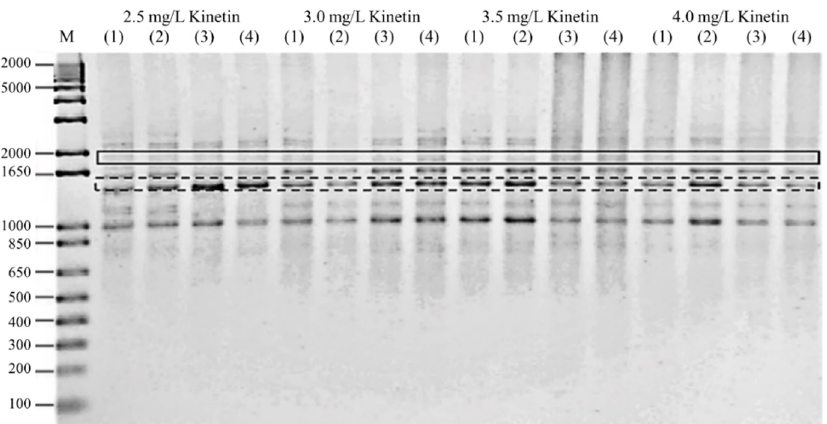
Figure 4. Gel image of PCR reaction on plantlets exposed to high cytokinin stress, obtained using ISSR primer UBC855. The polymorphic bands were highlighted using a solid line, while the monomorphic bands were shown using a dashed line. Table 7. Primers used in the ISSR polymorphism analysis, number and size of amplified fragments of Orthosiphon stamineus plantlets exposed to abiotic stress.